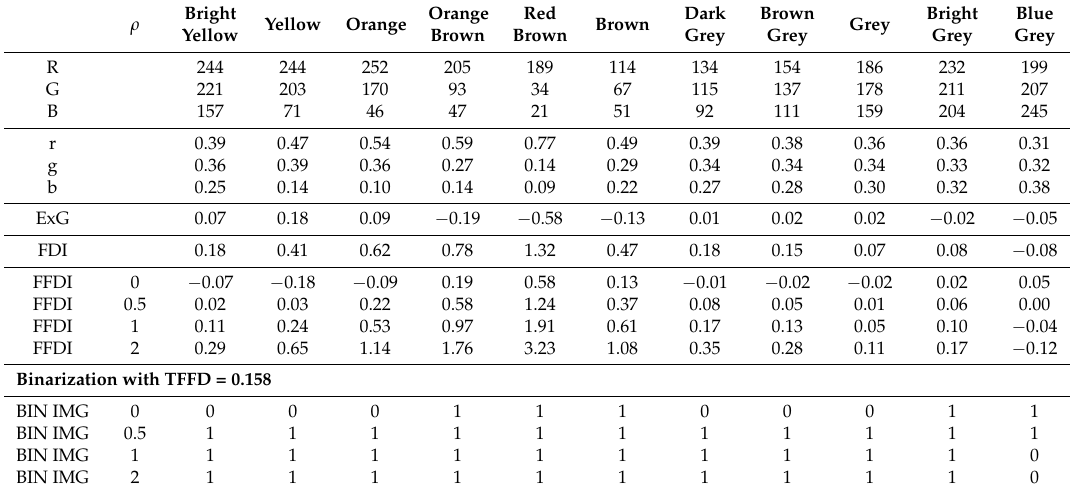
Table 1. Color component analysis for flame and smoke regions.